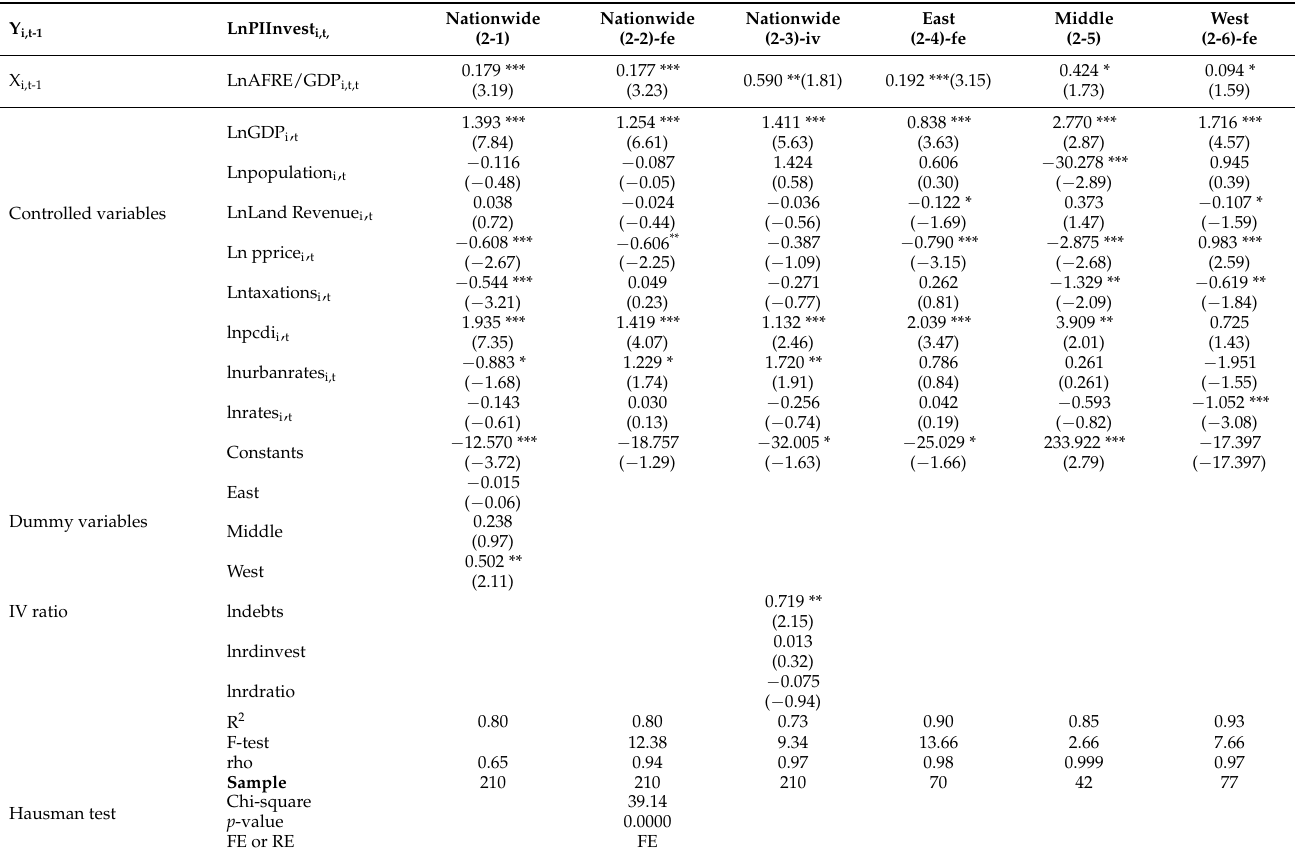
Table 4. Estimation results